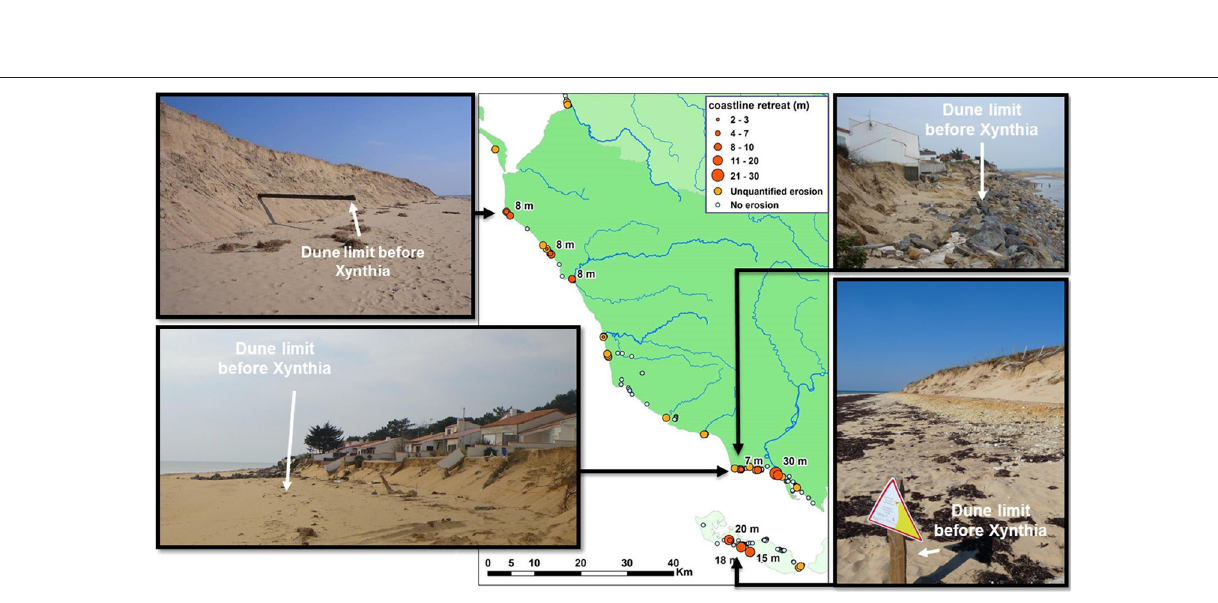
Frontiers in Marine Science | www.frontiersin.org